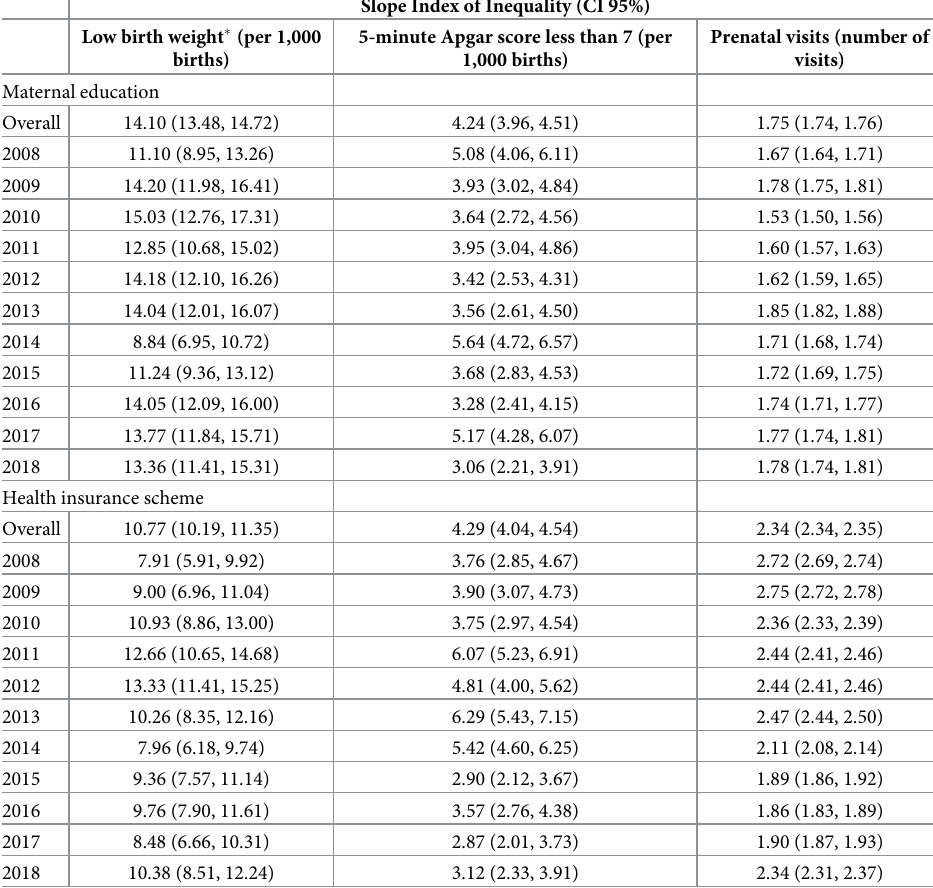
Table 2. Slope indexes of inequality in birth outcomes and prenatal care by maternal education and health insur- ance scheme,